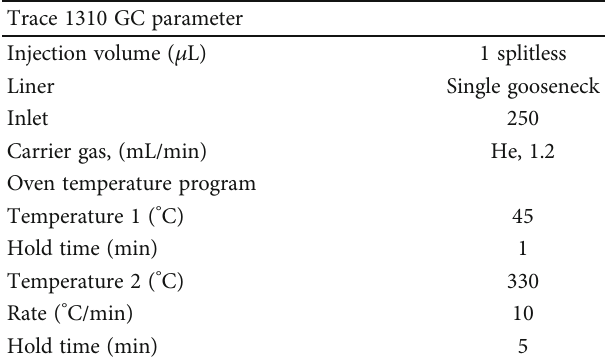
Table 2: GC-MS/MS and injector conditions.